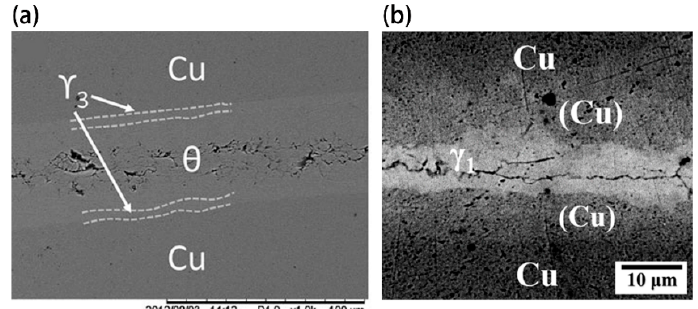
Figure 3. The backscattered images of ( a ) a Cu/Ga/Cu sandwich couple produced after 96 h at 160 °C [60]; ( b ) a Cu/Pt/Ga/Pt/Cu couple produced at 300 °C for 24 h [59], where γ 1 and γ 3 are γ 1 -Cu 9 Ga 4 and γ 3 -Cu 9 Ga 4 , respectively.